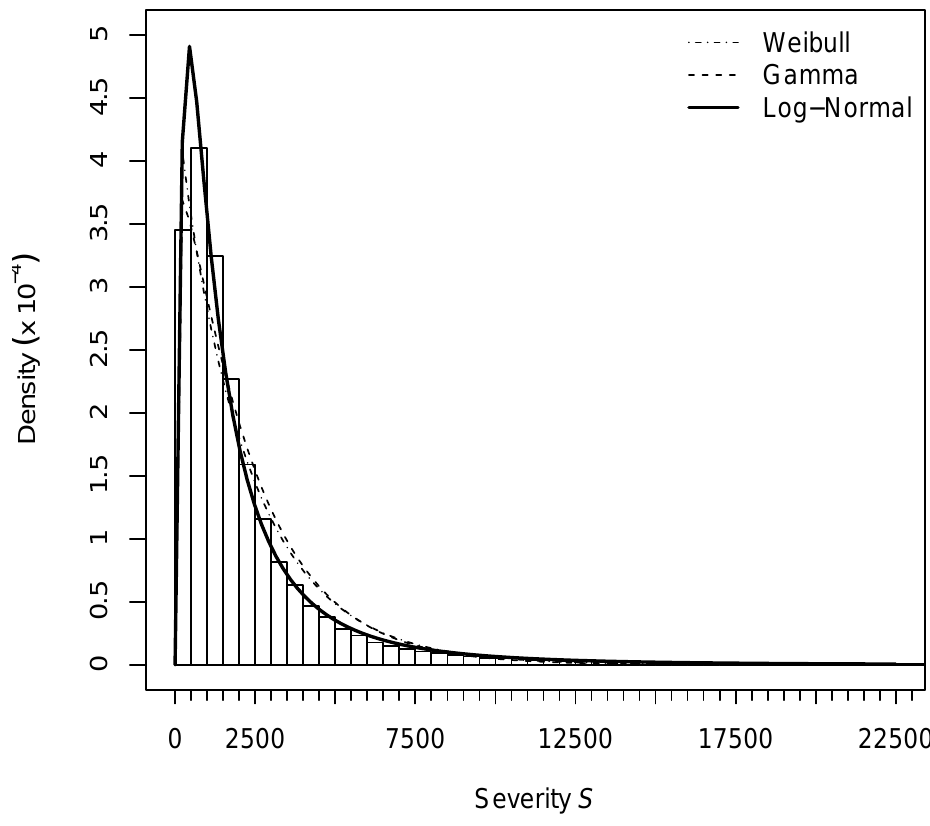
Figure 1. Illustration of the distribution of the claim severity S in the training dataset. Table 2. GOF statistics for the distribution of the claim severity S in the training